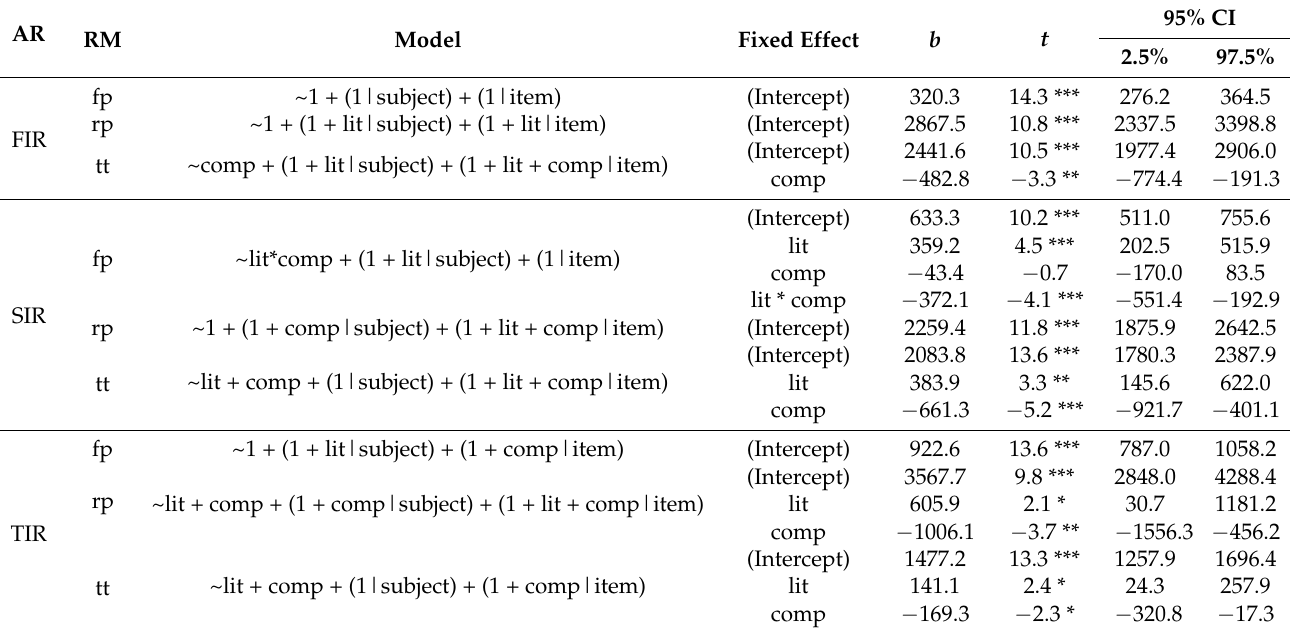
Table 3. Best fitting models and fixed-effects parameters and random